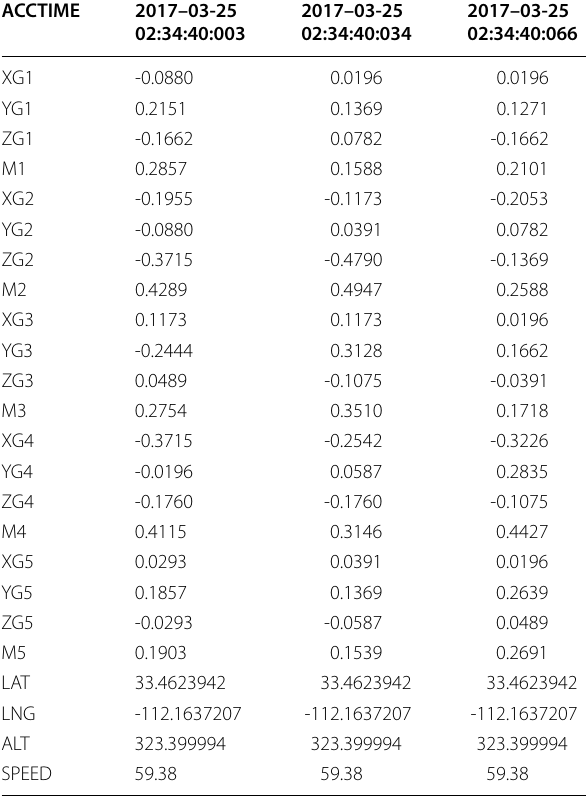
LAT, LNG, and ALT represent latitude, longitude, and altitude in geographic coordinates